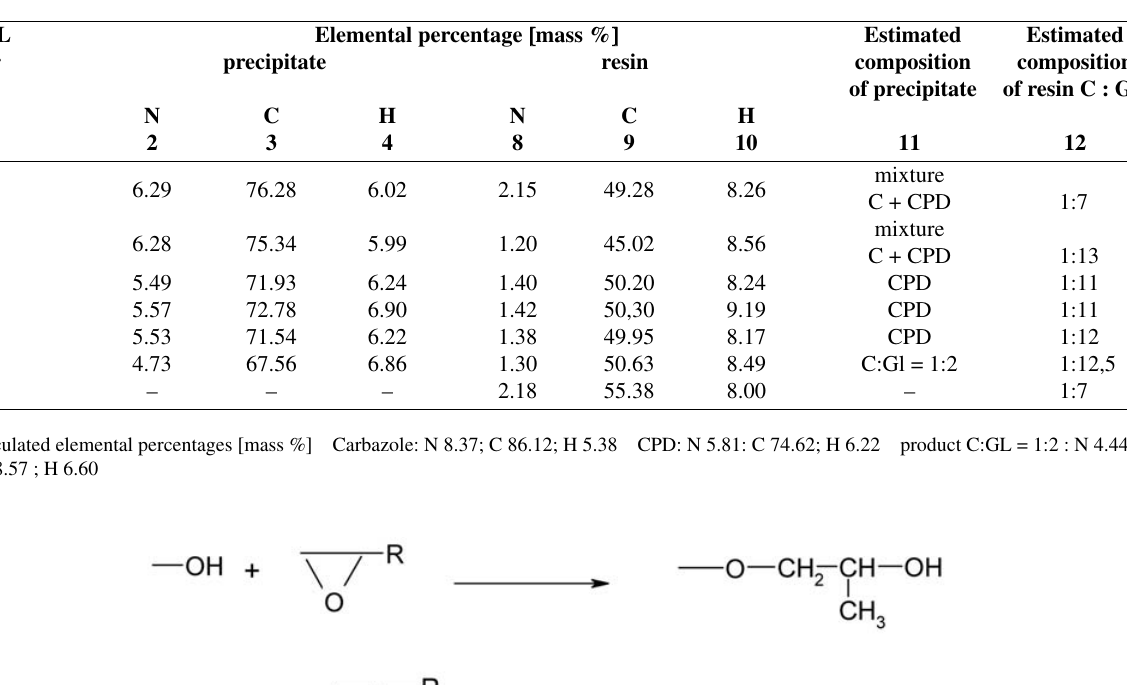
Lubczak: New Method of Synthesis of Oligoetherols ...